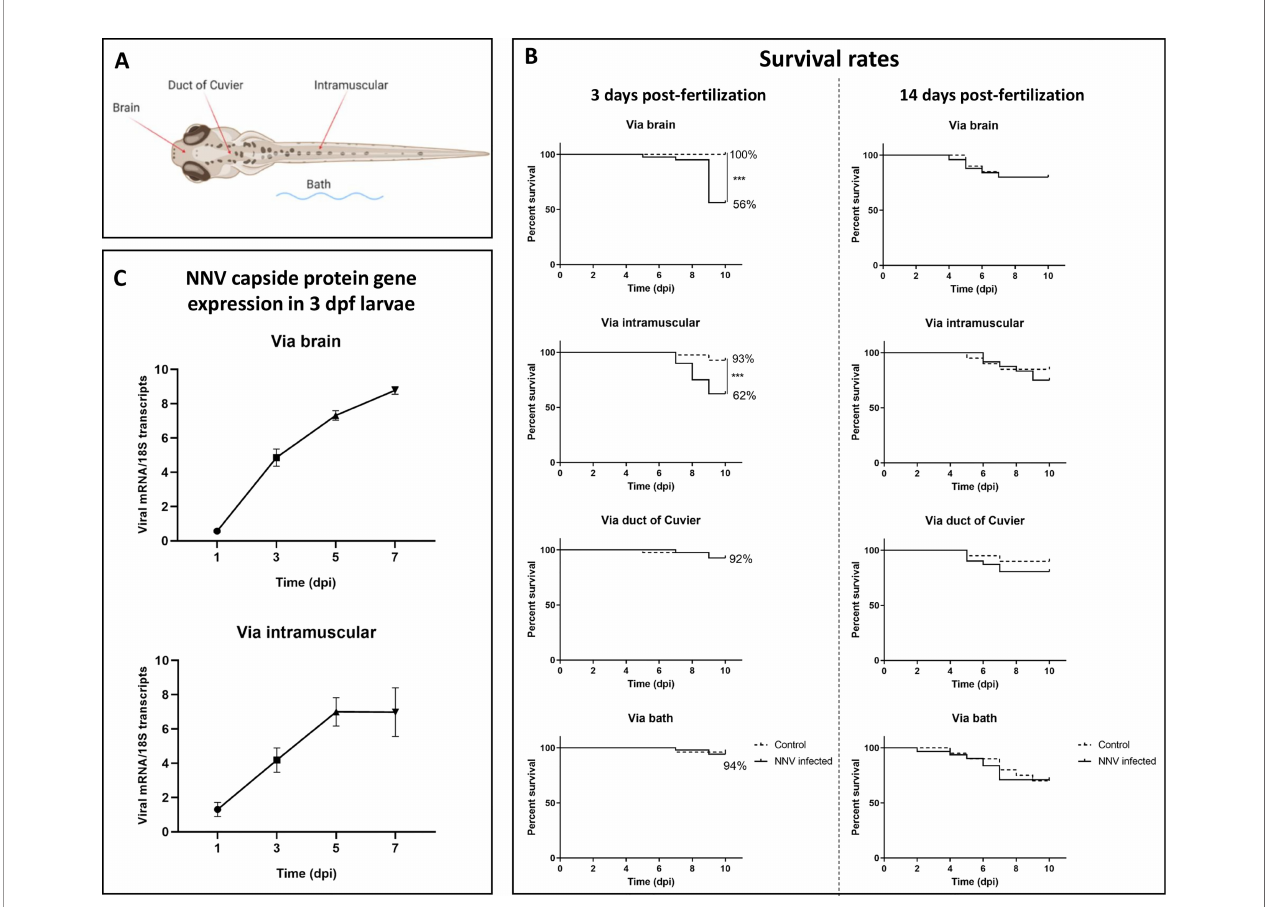
FIGURE 1 | Survival rates of zebra fi sh larvae challenged with NNV through different infection routes and NNV replication. (A) Schematic representation of the different infection routes used to determine the susceptibility of zebra fi sh larvae to NNV. (B) Kaplan – Meier survival curves of NNV-infected and uninfected larvae in 3- and 14-dpf larvae. Mortality was registered during the next 10 dpi. (C) Quanti fi cation of NNV capsid protein gene expression in 3-dpf larvae infected via the brain or intramuscularly at different sampling points through qPCR; data are presented as the mean ± SEM of biological replicates. Statistically signi fi cant differences are displayed as follows: ***, 0.0001 > p value >